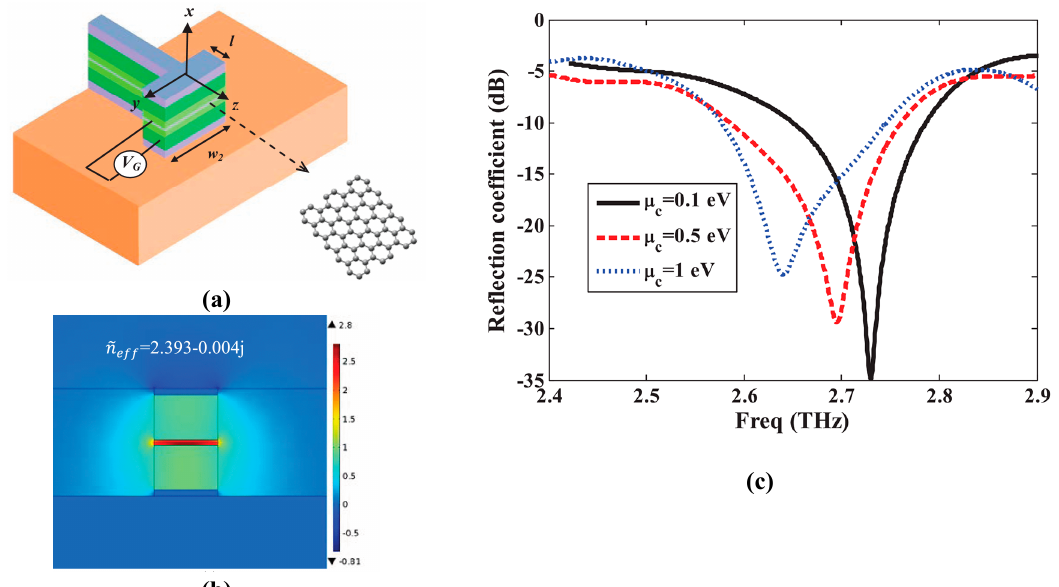
Figure 4. ( a ) Graphene stack antenna with waveguide graphene–metal hybrid structure fed, where the gate voltage is applied to graphene layers and the antenna substrate is quartz with silicon stack; ( b ) effective refractive index mode of graphene–metal waveguide; and ( c ) reflection coefficient of the proposed antenna as a function of chemical potential, where, as the chemical potential is increased to µ = 1 eV, the resonance frequency becomes lower side. © Springer 2019. Reprinted with permission from [103].